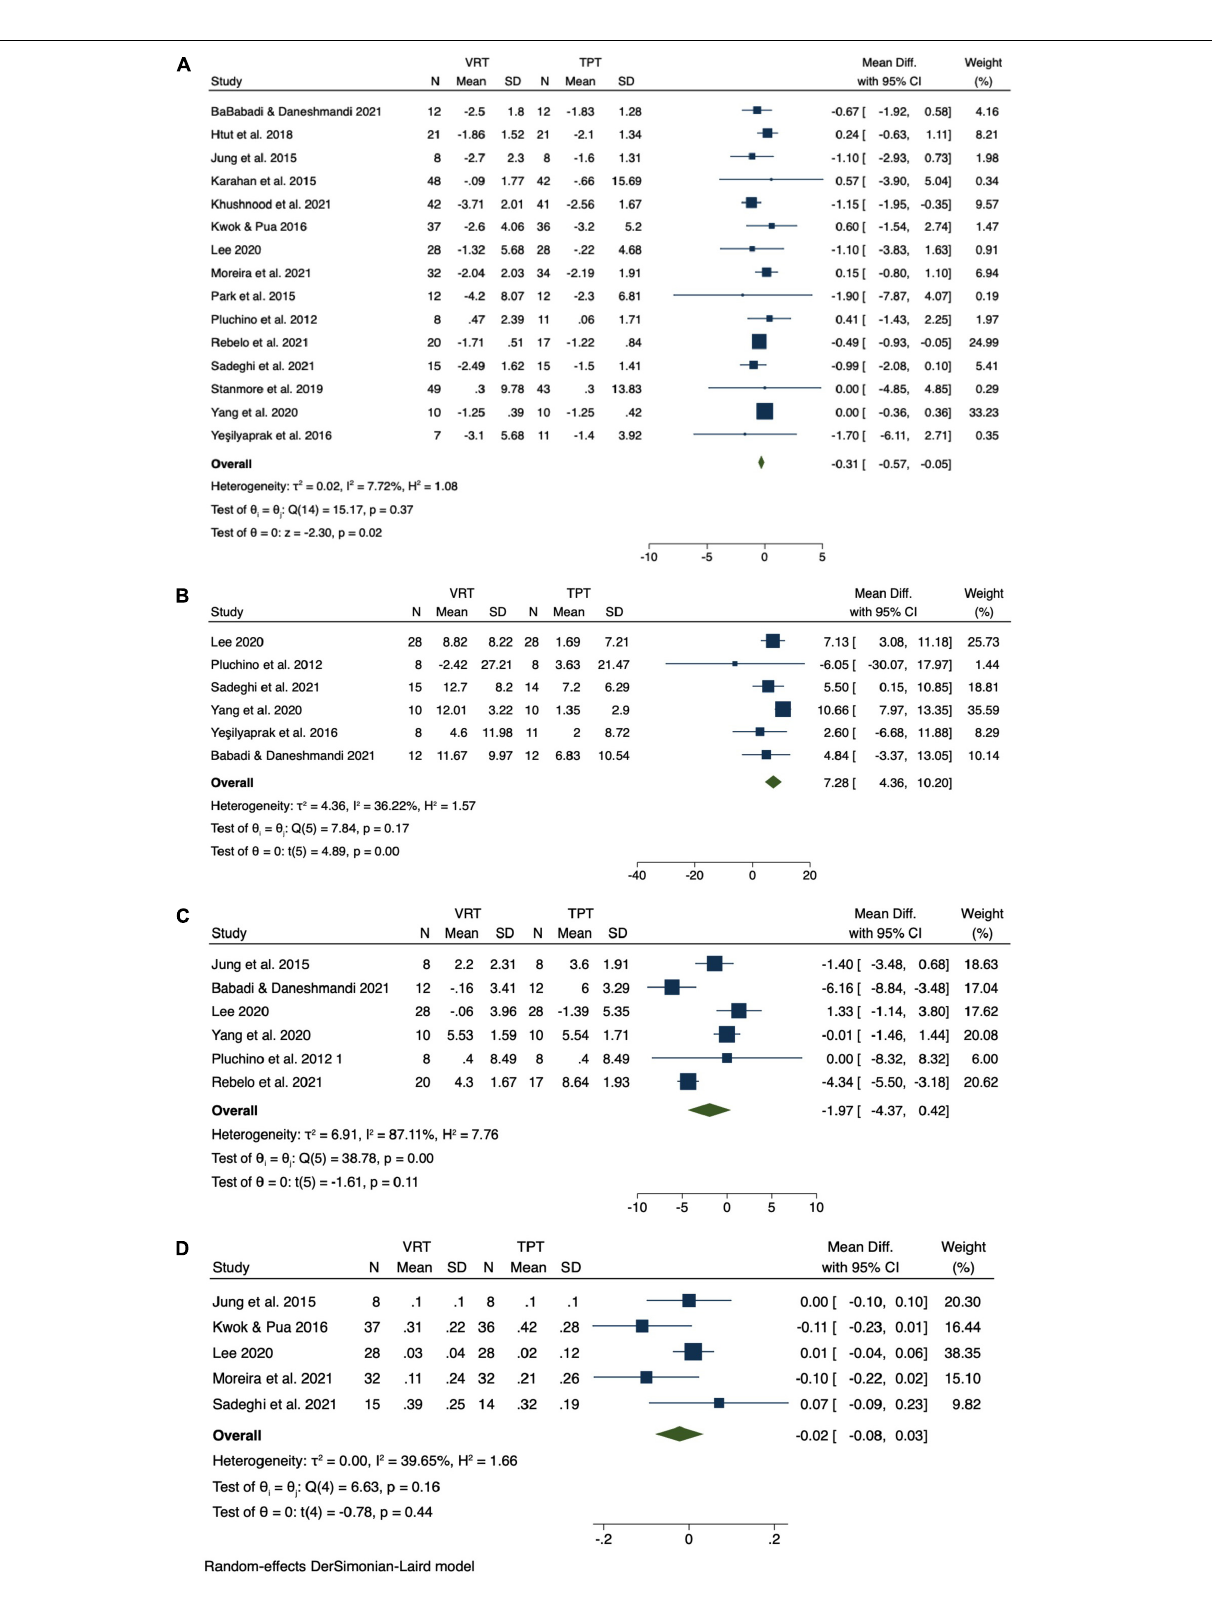
FIGURE 3 | Result of meta-analysis. (A) Timed Up and Go (TUG), (B) one-leg stance with open eyes (OLS-O), (C) functional reach test (FRT), and (D) gait speed (GS).